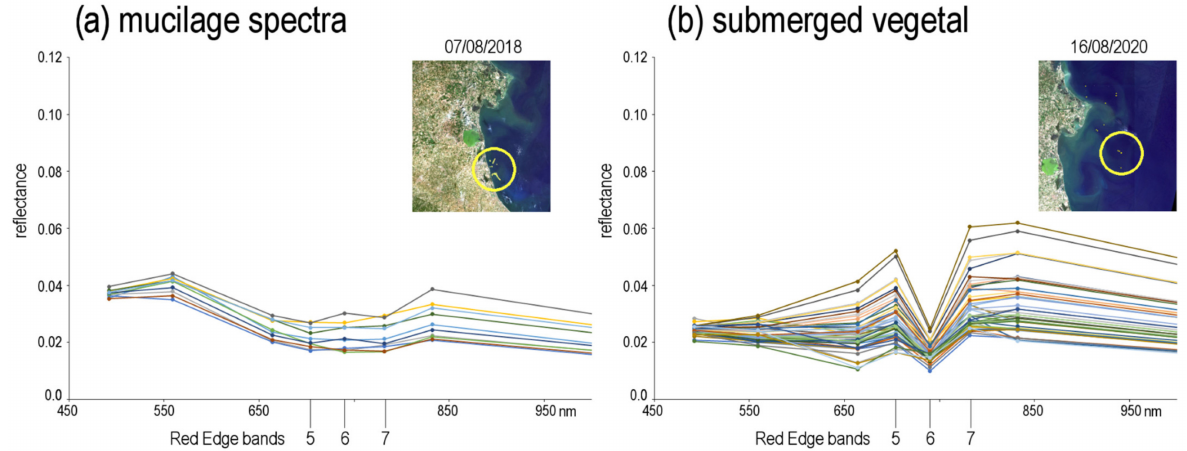
Figure 6. ( a ) Mucilage spectra south of the Po estuary (top-10 pixels in band 8) detected in a Sentinel-2 scene acquired in summer 2018. ( b ) Pixel spectra classified as submerged vegetal materials detected in August 2020.